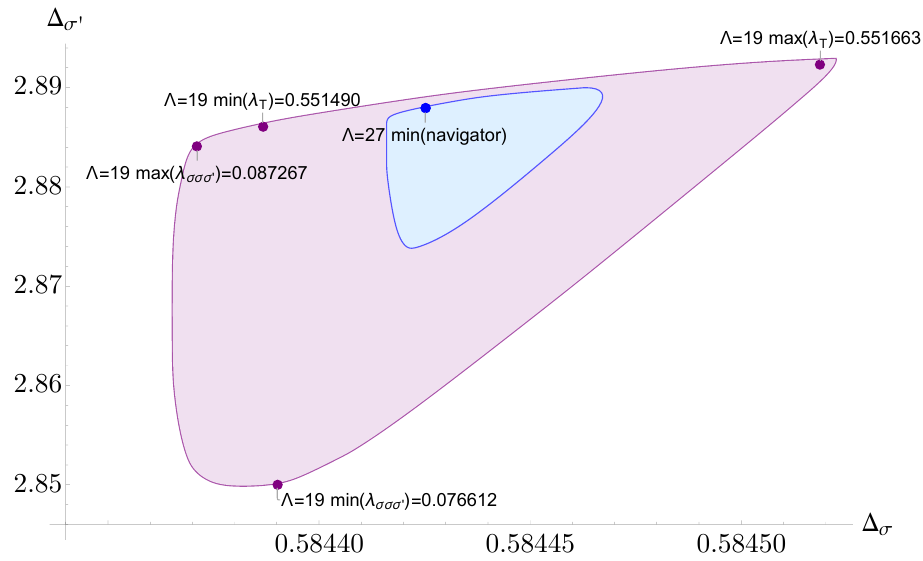
Figure 6 . The locations of the final points from various navigator runs. Purple points: locations where various OPE coefficients are maximized/minimized at Λ = 19 . λ T is defined as λ σσT / ∆ σ . Blue points: the location where navigator value is minimized at Λ = 27 . Purple area: Λ = 19 allowed region. Blue area: Λ = 27 allowed